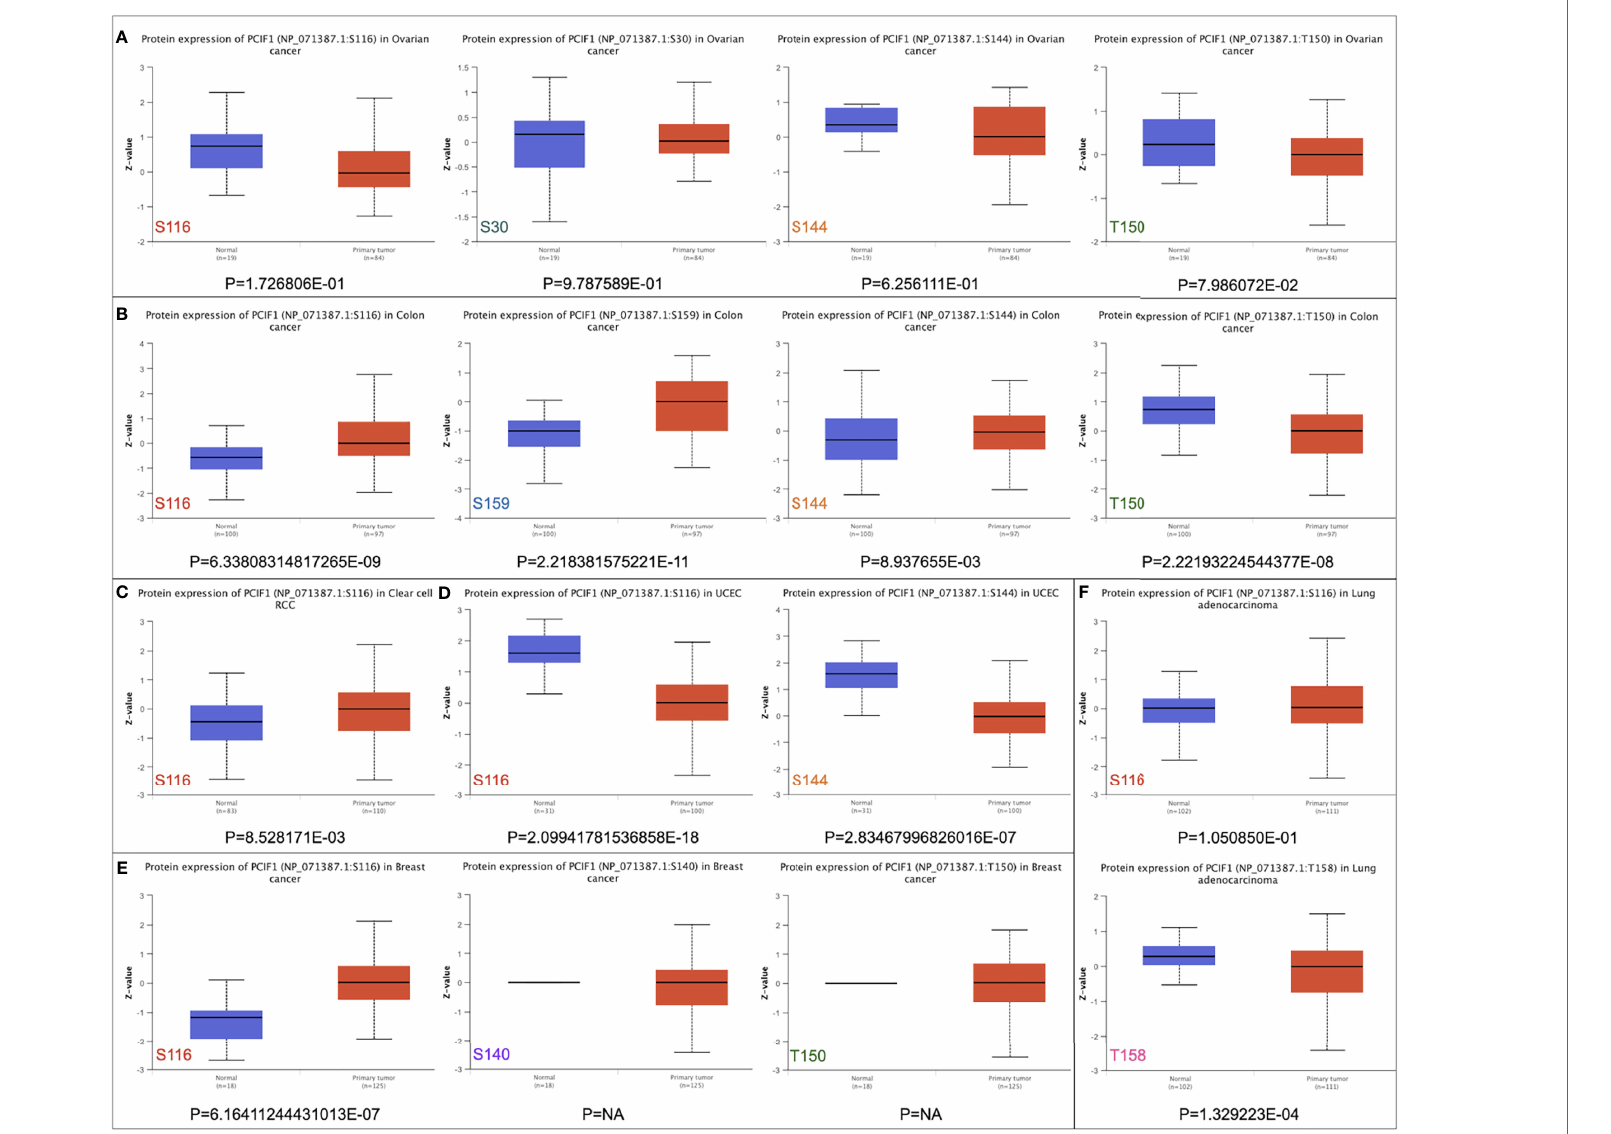
FIGURE 4 | Phosphorylation of PCIF1 protein between normal and primary tumor sites based on the CPTAC dataset. (A) Ovarian cancer. (B) Colon cancer. (C) Clear-cell RCC. (D) UCEC. (E) Breast cancer. (F) Lung